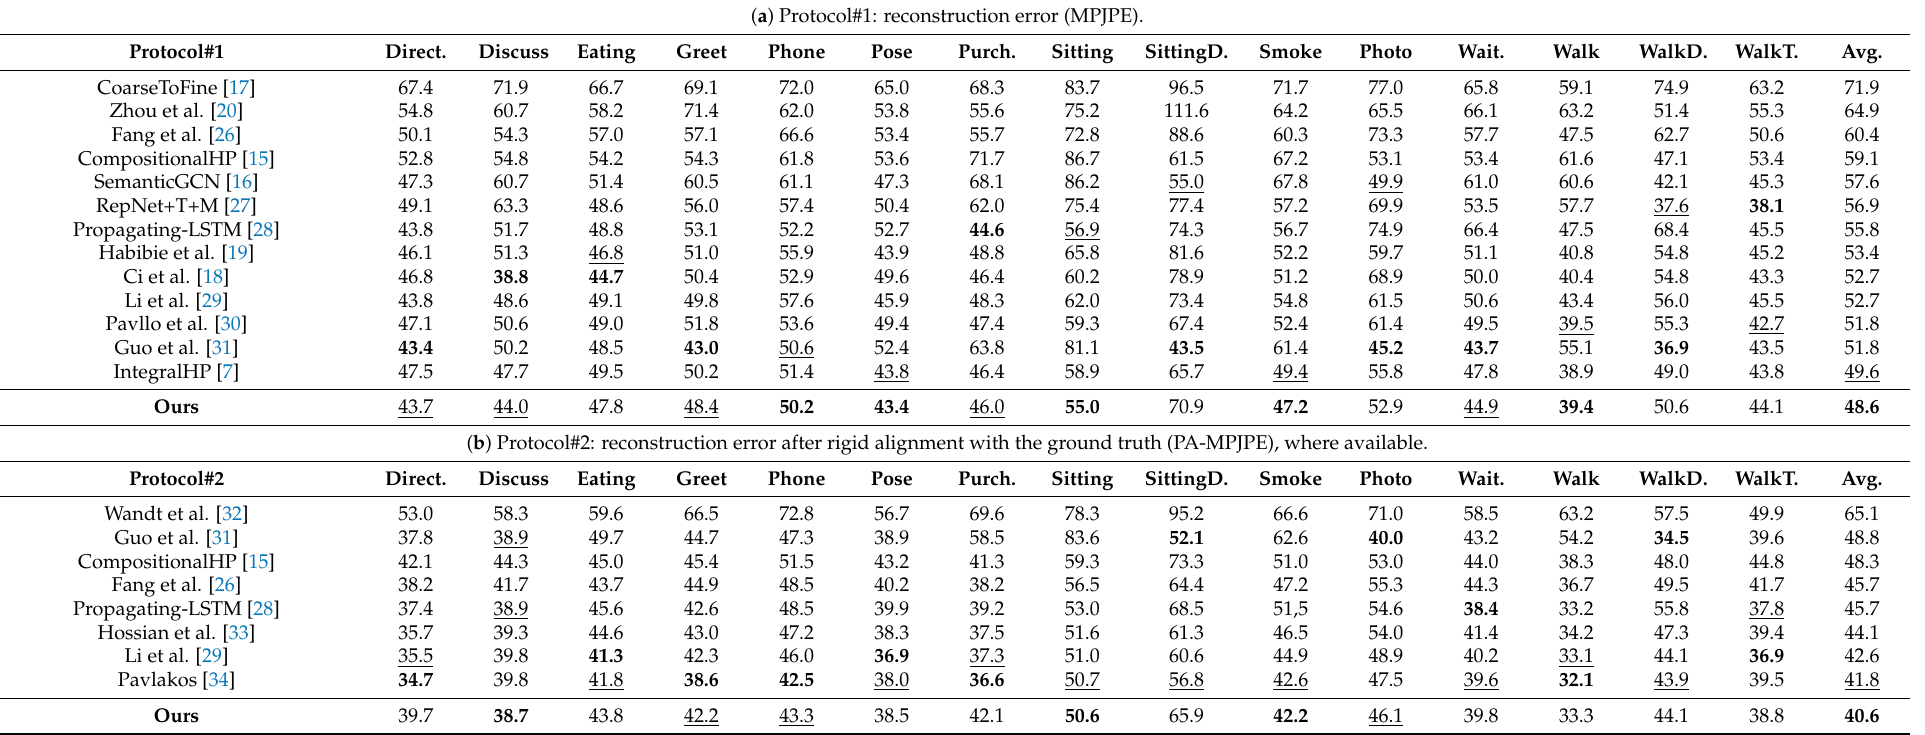
Table 3. Comparison of mean per joint position error (mm) in Human3.6M between the estimated pose and the ground truth. Lower values are better, with the best in bold, and the second best